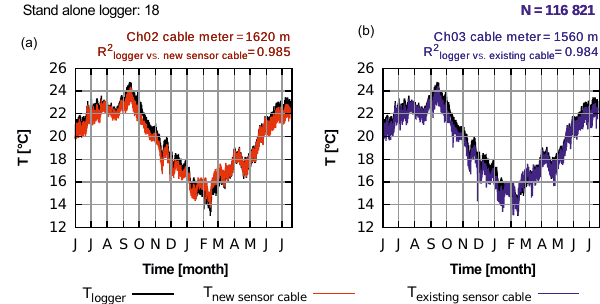
Figure 5. Comparison of measured temperatures by new sensor ca- ble (a) and pre-installed communication cable (b) with stand-alone control temperature loggers at the same position (top), and their cor- relations